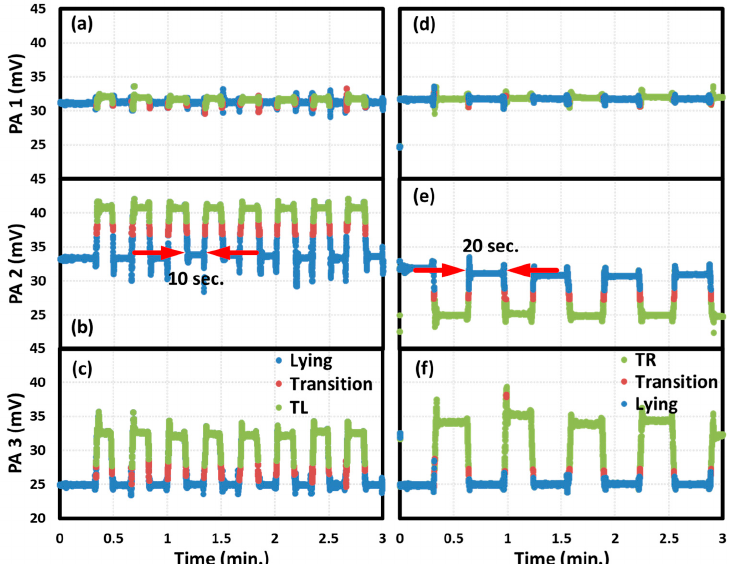
Figure 3. The original time signals collected from each corresponding sensing axis of the G-sensor. The analog signals delineated from ( a – c ) describes the motional patterns of a human from lying face-up to turning left (TL), whereas those from ( d – f ) show the patterns from face-up to turning right (TR). The experiments were repeated eight times within three minutes with two different time periods, 20 and 40 s. The results classified using the DDFM are also exhibited in each plot in advance. PA = principal axis.